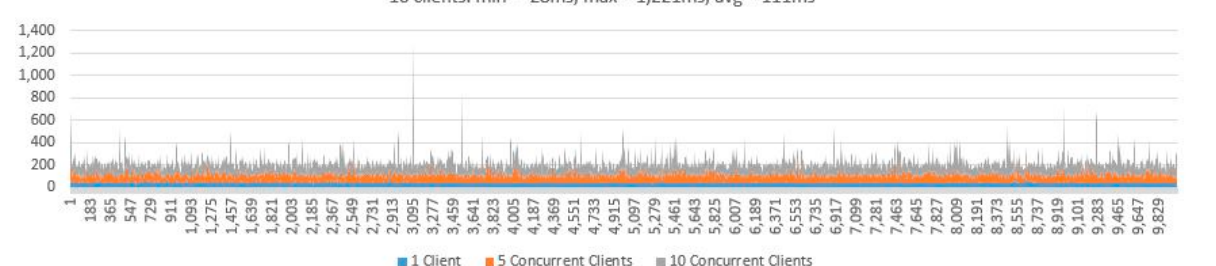
Figure 14. Response times from Get TPGU Access Token for 10,000 calls.